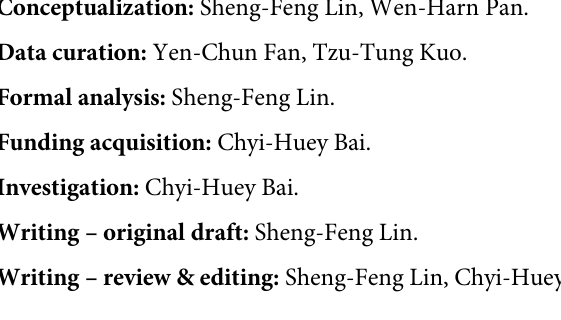
S1 Table. Mini-Mental State examination and quality of life assessment stratified by sex. S2 Table. Spearman correlation coefficients among all items of the Mini-Mental State examination and